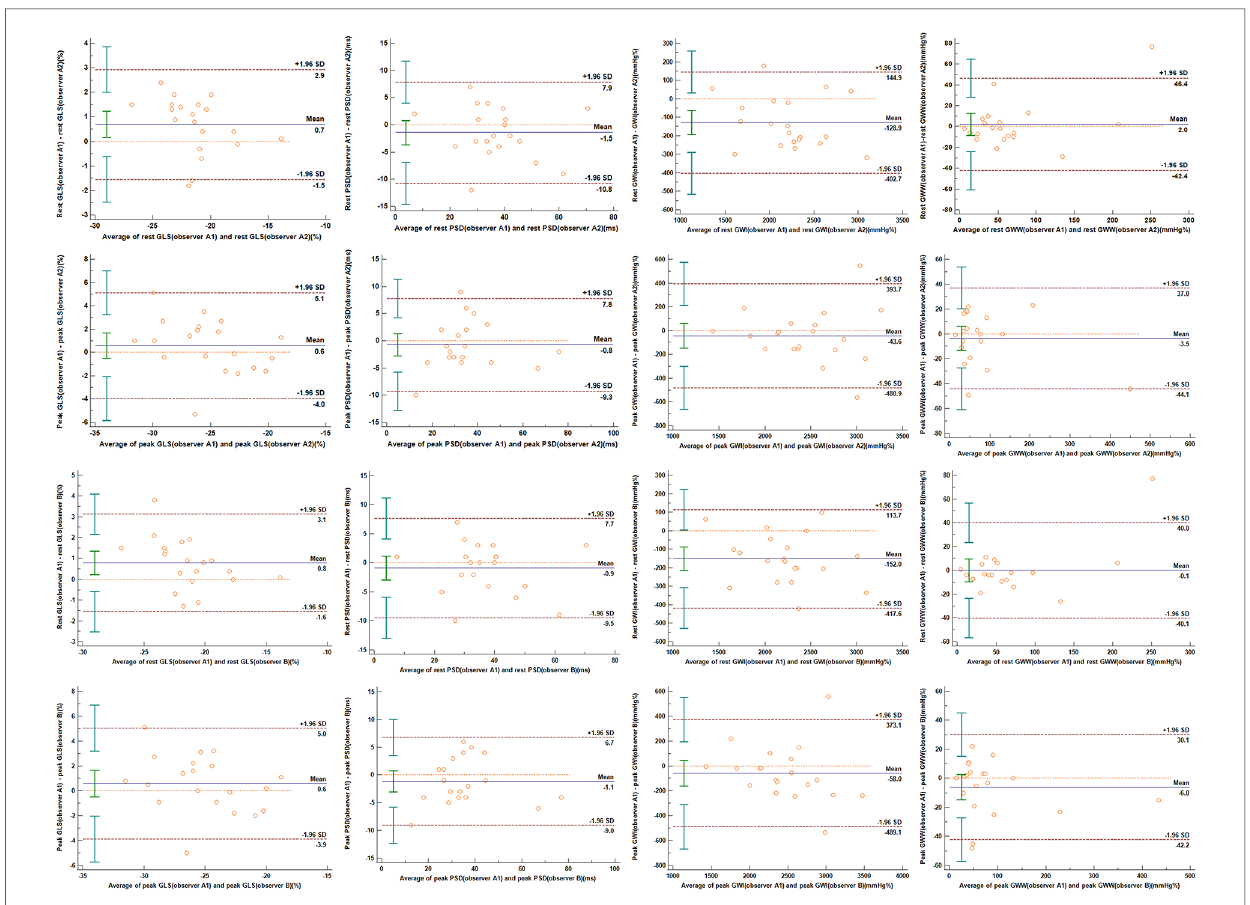
FIGURE 5 Bland – Altman plots indicating intra-observer and inter-observer variabilities in 2D-STE and MW indices. The upper and lower dotted lines indicate 95% limits of agreement, while the middle dotted line indicates the zero line. The solid line represents the mean difference between the two measurements. ( A ) Intra-observer variability; ( B ) interobserver variability. GLS, global longitudinal strain; PSD, peak strain dispersion; GWI, global work index; GWW, global waste work.